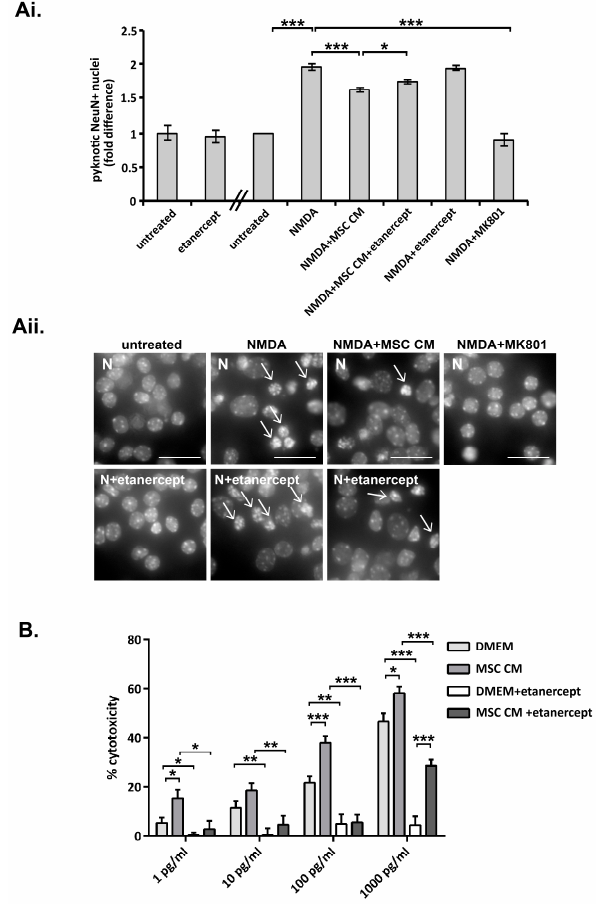
Figure 2. TNF is produced by MSC and contributes to MSC CM-mediated neuroprotection against glutamate excitotoxicity. ( A ) DIV 9 neurons (N) were pre-treated with high glucose DMEM medium alone (hgDMEM) or MSC CM without or with etanercept (100 ng/ml) (24 h), then left untreated or challenged with NMDA (50 μ M) supplemented with glycine (10 μ M) (24 h), and death was measured at DIV 11 by Hoechst staining. Etanercept treatment consistently resulted in a small but significant increase in NMDA-induced excitotoxicity, as measured by fold changes in proportions of cells with pyknotic nuclei compared to those in cells treated with MSC CM alone ( Ai and ii , arrows show pyknotic nuclei). Neuron death is represented as fold differences compared to measurements in untreated cultures ( Ai ). Representative fields from each culture are shown in the photographs ( Aii ). ( B ) TNF-induced cytotoxicity of L929 fibroblasts was measured in the presence of 1 µ g/ml emetine, using increasing amounts of recombinant human TNF (rhTNF) (1, 10, 100 and 1000 pg/ml) added to non-conditioned hgDMEM or MSC CM without or with etanercept (200 ng/ml). MSC CM consistently induced more cytotoxicity than non-conditioned hgDMEM at each concentration of added rhTNF used, demonstrating that MSC CM contains TNF bioactivity (estimated between 0.15–0.24 U/ml). Etanercept inhibited cytotoxicity in all preparations showing that cytotoxicity was specifically induced by TNF. Scale bars 50 µ M. Results shown are means ± SEM of triplicate samples from one representative of three independent experiments. * p < 0.05, ** p < 0.005, *** p < 0.001, for pairwise comparisons by Student’s t